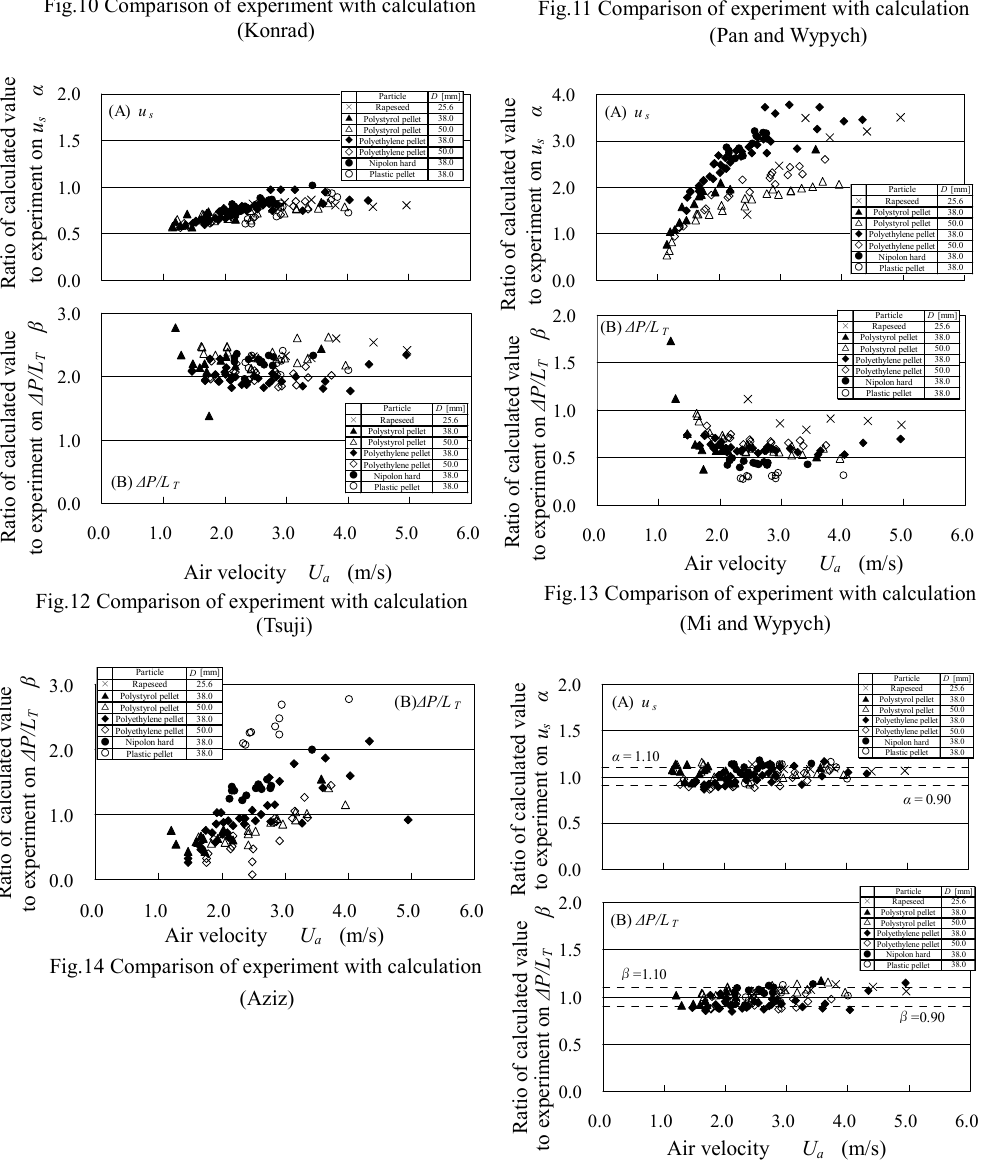
Fig.10 Comparison of experiment with calculation